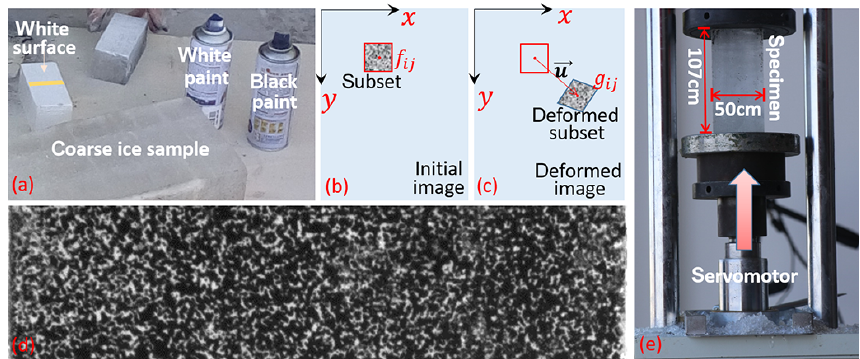
Figure 1. Specimen preparation, definition of coordinates and loading system. (a) Black/white speckles from spraying the oil paints onto the specimen surfaces. (b–c) The matching process between the initial subset and the deformed subset. (d) A magnified section of the prepared specimen corresponding to the yellow line in panel (a) . (e) The load applied the specimen from bottom to